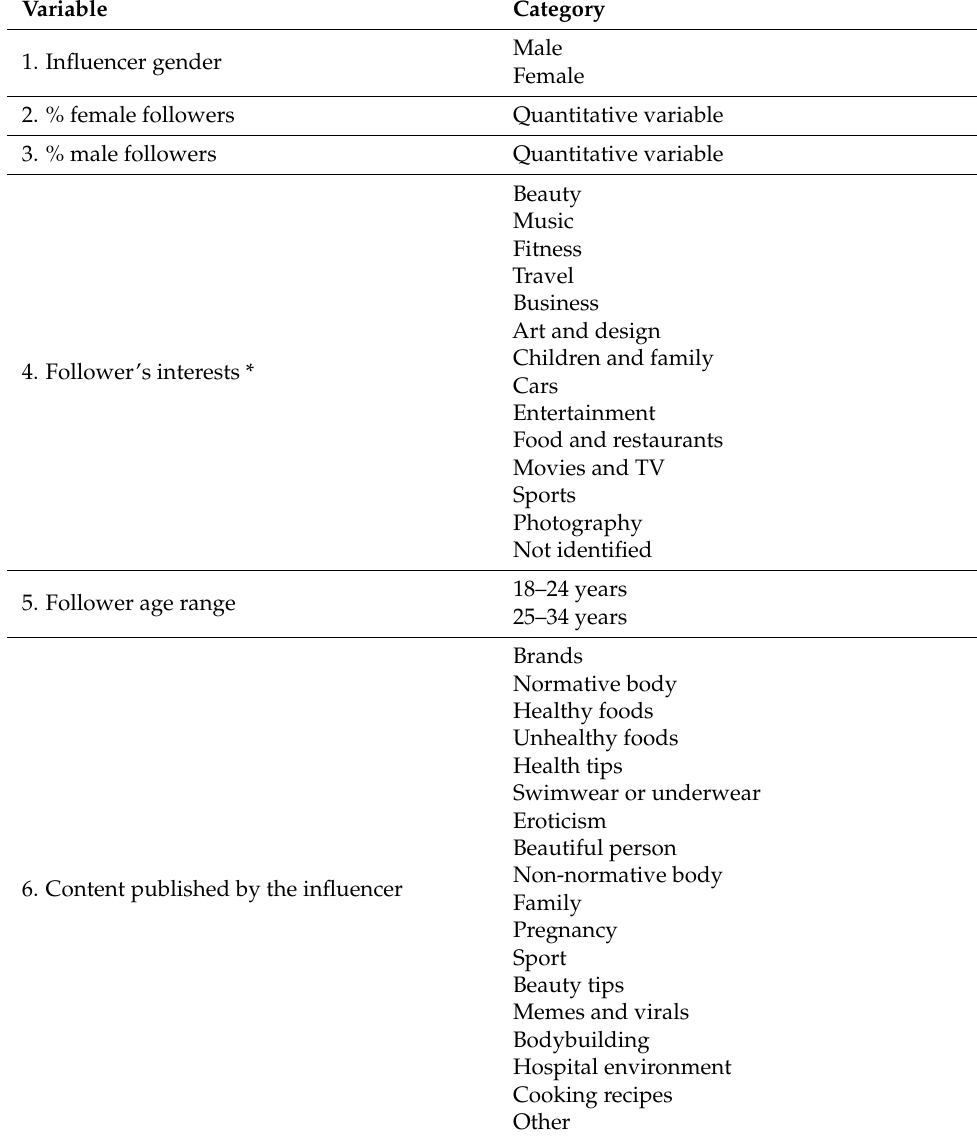
Table 1. Codebook. Source: own